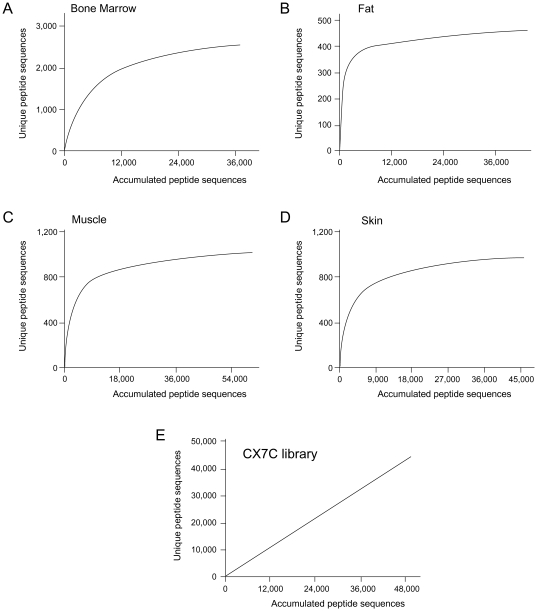
Saturation plots of peptide diversity coverage after next-generation sequencing.The plot shows the number of distinct peptides observed in bone marrow (A), fat (B), muscle (C), skin (D) or the non-selected library (E), as a function of the total number of sequences evaluated for each tissue after filtering. All tissues investigated attained or nearly attained saturation (as determined by the predicted number of distinct peptides in each tissue), whereas nothing approaching saturation was observed for the unselected library (straight line).